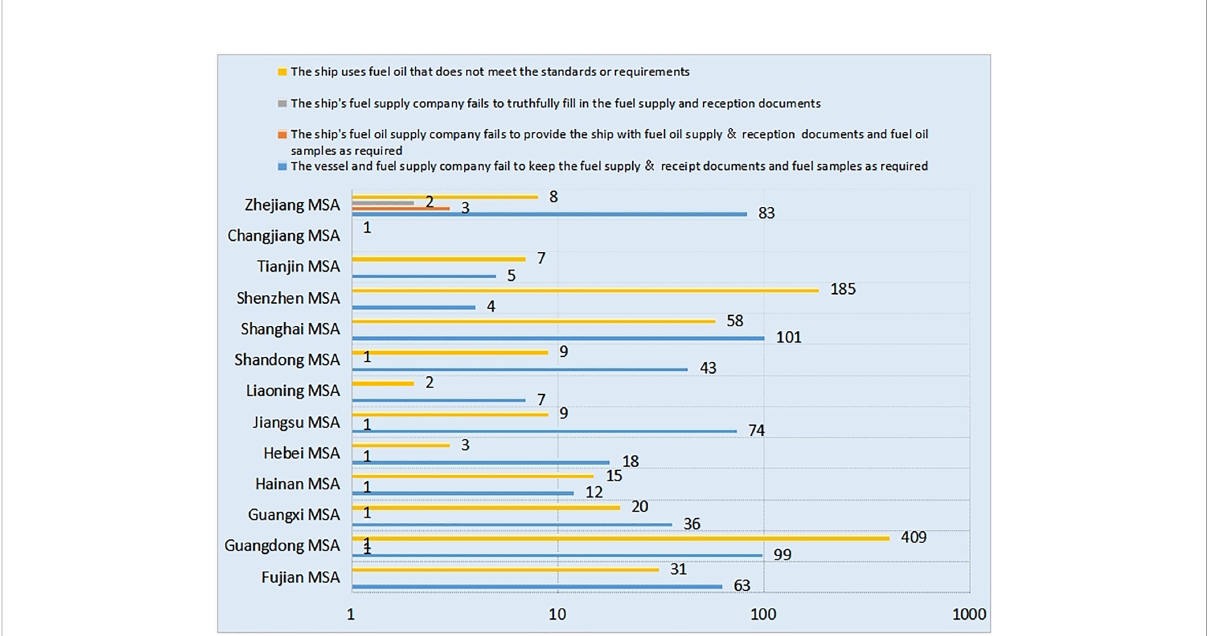
FIGURE 3 Proportion of different case types from local Maritime Authorities. Source: The website of Maritime Safety Administration of the P. R. C and local Maritime